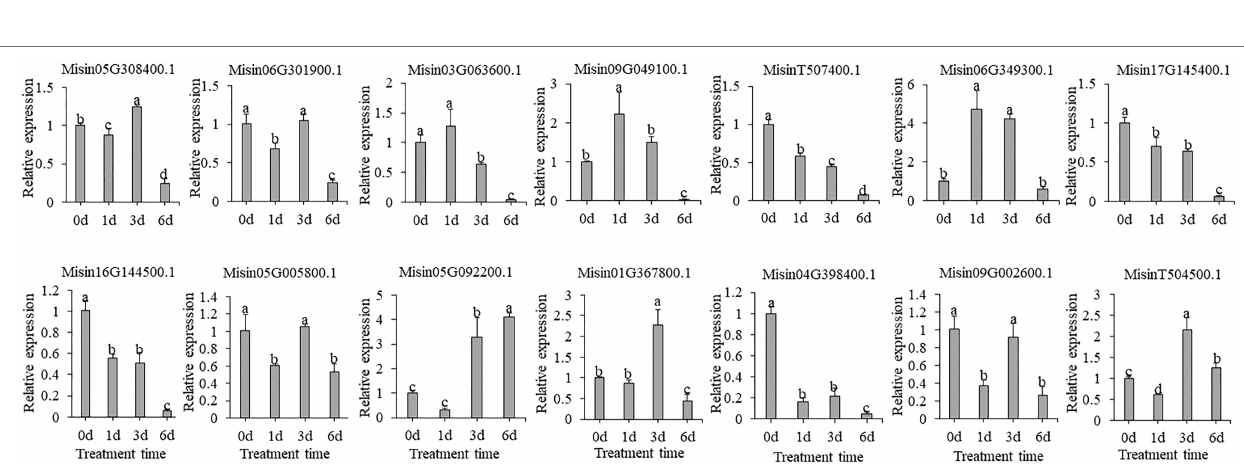
FIGURE 7 | Expression profiles of 14 selected M. sinensis NAC genes in response to PEG treatment. Data were normalized to reference gene Unigene33024, and vertical bars indicate SD. No common letter above bar indicates a significant difference by least significant difference (LSD; p <